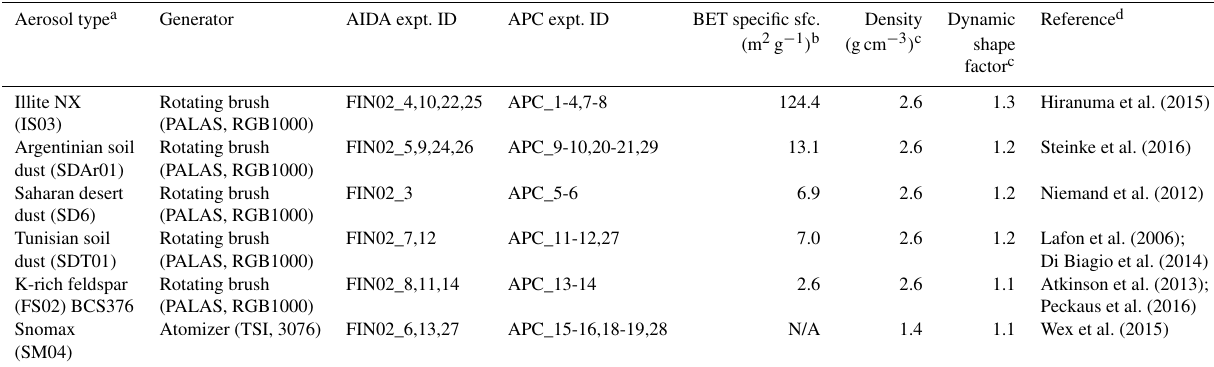
Table 3. List of aerosol types, particle generation techniques, and aerosol properties. Aerosol type a